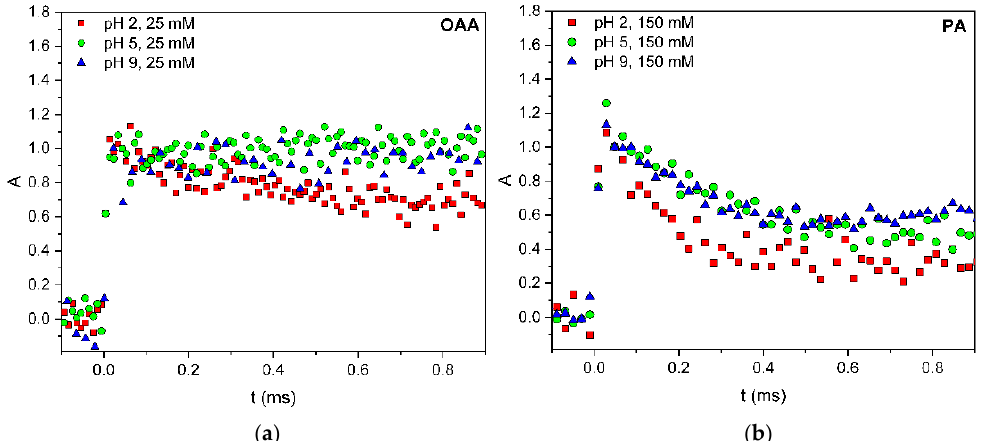
Figure 3. ( a ) Pulse radiolysis of N 2 O-saturated aqueous solutions containing 25 mmol dm − 3 poly(acrylic acid) at various pH. Normalized absorbance at λ = 280 nm as a function of time after pulse. Dose per pulse around 60 Gy. ( b ) Half-life of PAA radicals in N 2 O-saturated aqueous solutions containing 10 mmol dm − 3 PAA as a function of pH, and schemes depicting the change in polymer conformation.